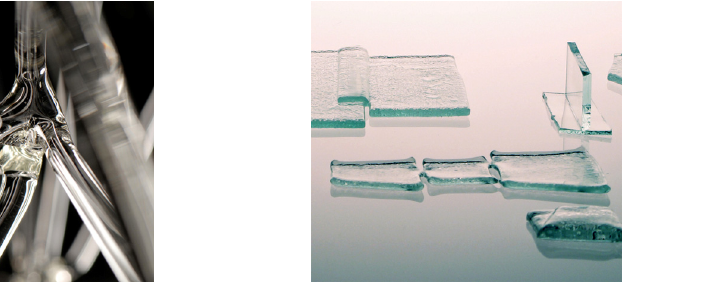
Figure 5: Glass-glass joint. Figure 6: Linear welding study